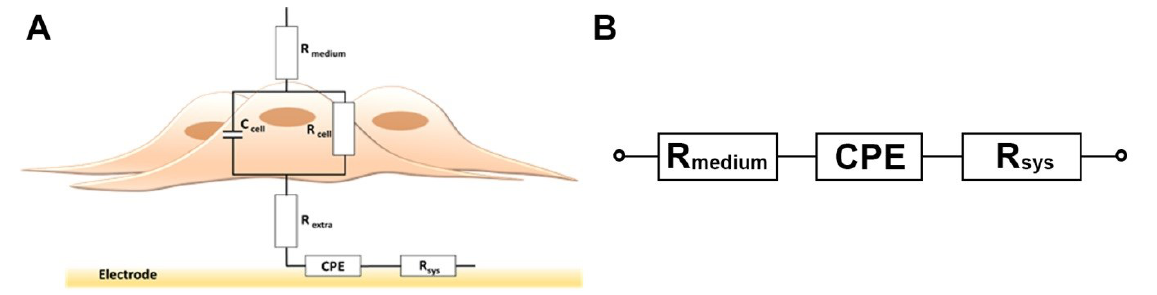
Figure 6. Equivalent circuit models for analysis of impedance spectra acquired A ) in the presence and B ) in the absence of cells. ( Cell specific parameters : R extra , R cell , C cell ). For detailed description of the components, see the